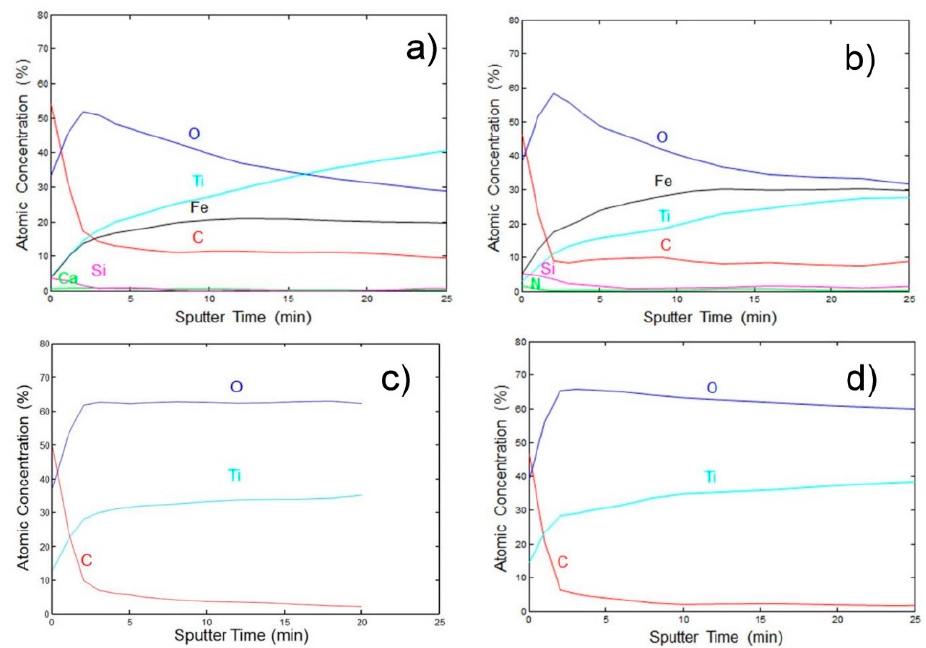
Figure 8. XPS depth profiles for ( a ) low alloyed Ti surface, ( b ) low alloyed Ti surface after exposure to corrosive environment, ( c ) laser marked Ti- Laser_100_3 sample before and ( d ) laser marked Ti-Laser_100_3 sample after exposure to corrosive environment. Sputtering rate was ~1 nm/min.